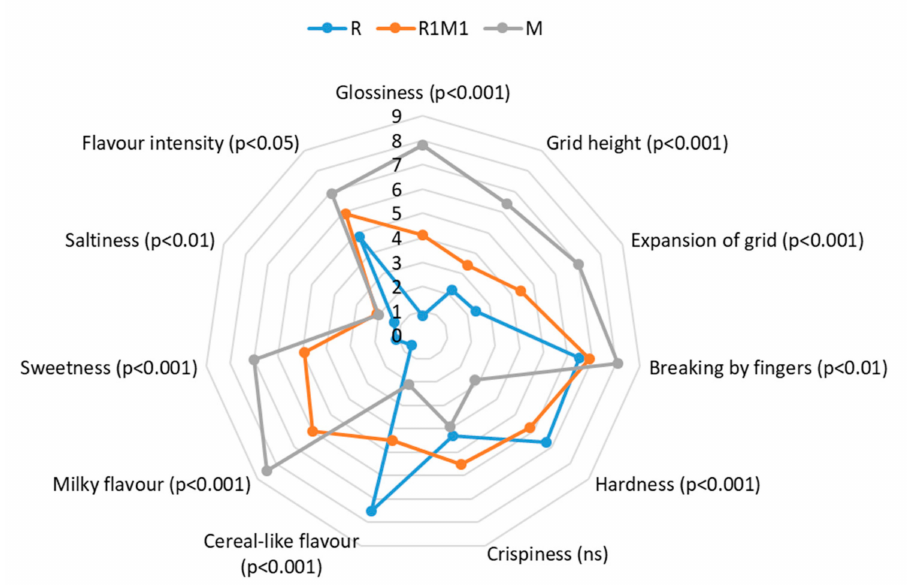
Figure 6. Results of the sensory profiling ( n = 2 × 10) of the printed and baked single-layer samples. The level of the statistical significances of the di ff erence between samples is marked by the p -value or ns (not